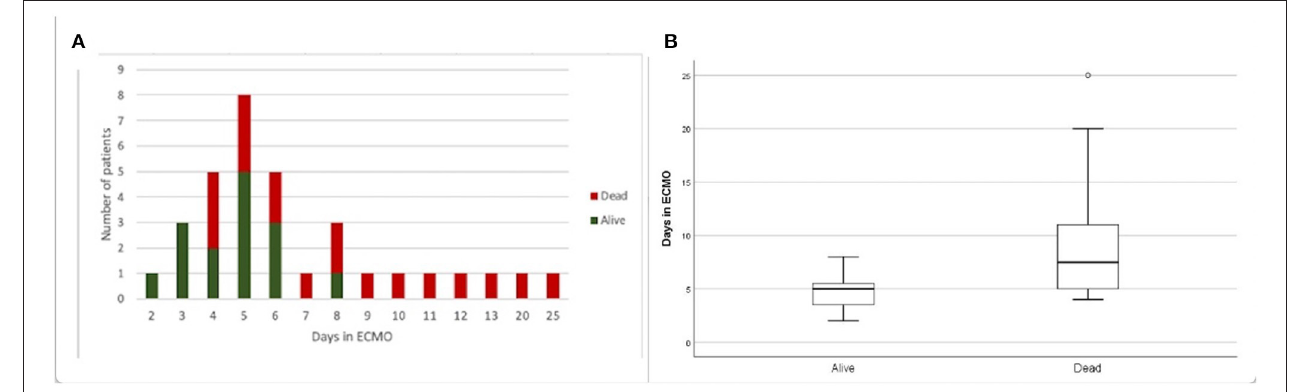
FIGURE 2 | Survival according to time under ECMO support. (A) Frequency of dead and alive patients submitted to different durations (2–25 days) of ECMO support. (B) Comparison of days under ECMO support for dead and alive patients. Tukey boxplot, whiskers represent 1.5 interquartile range. *Mann–Whitney U- test, p = 0.004.